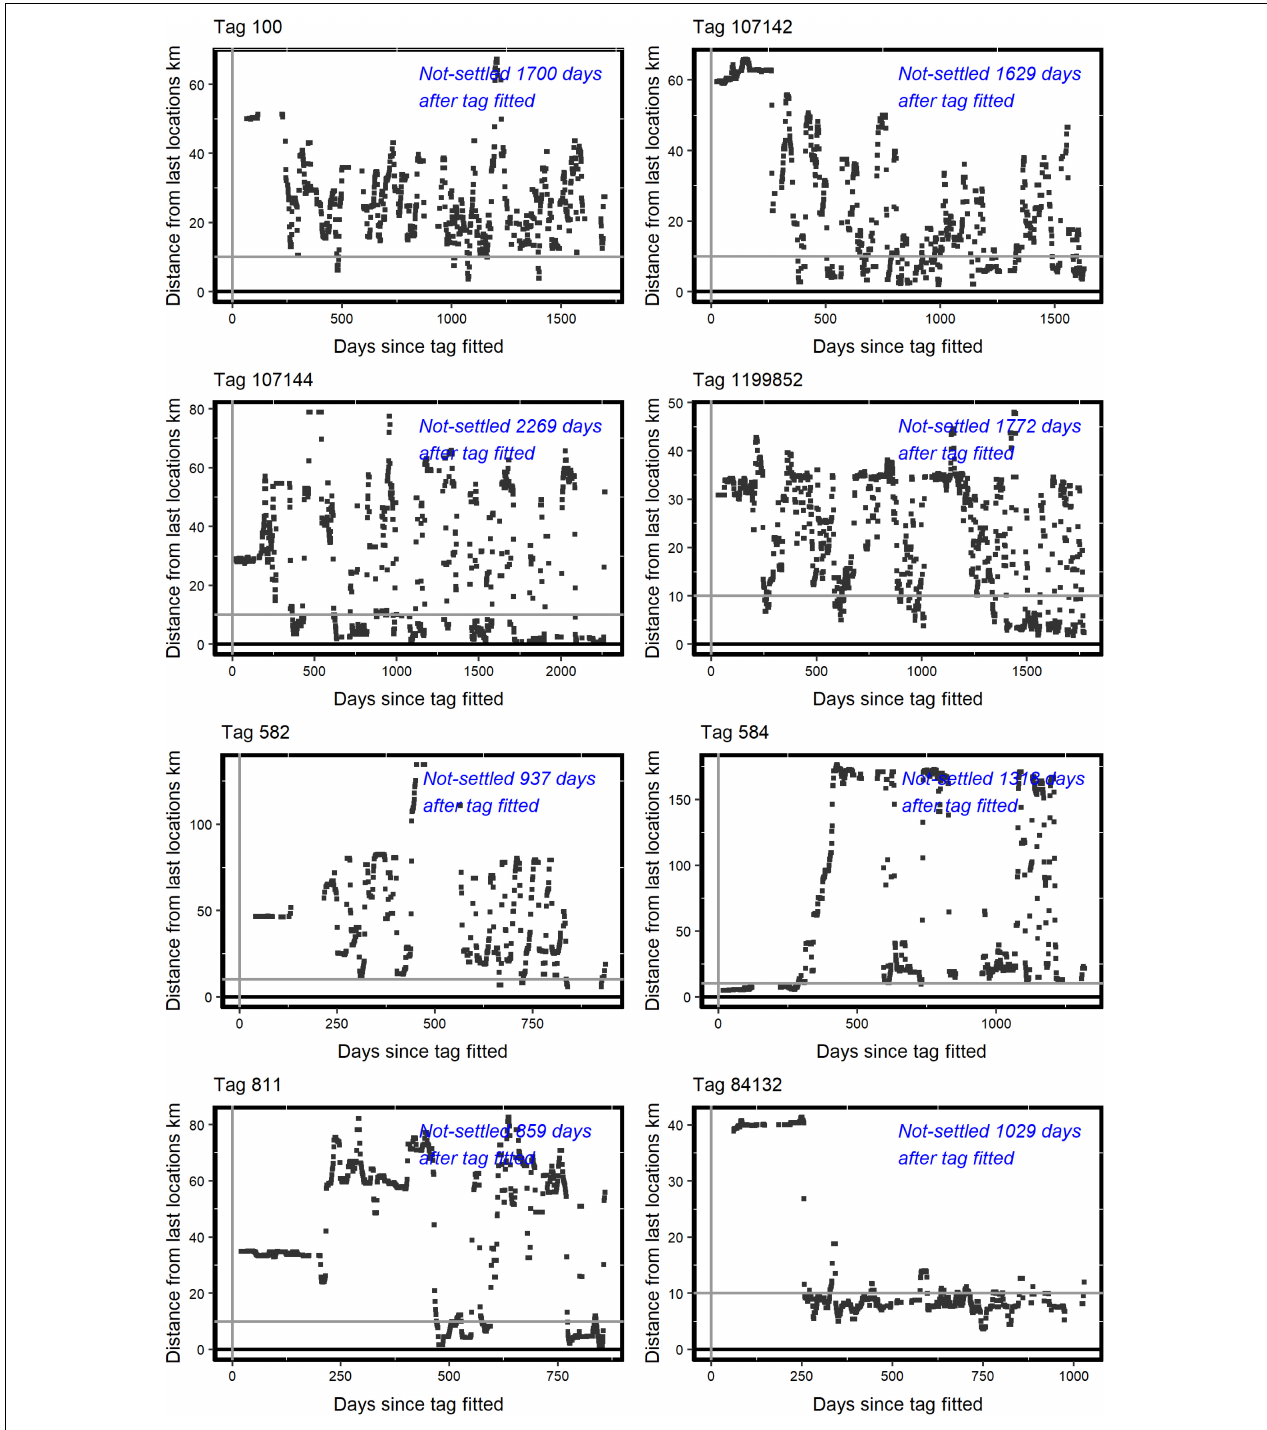
FIGURE 3 | Examples for eight tagged birds (identified, upper left above each panel) deemed not to have algorithmically settled on a putative breeding territory according to Distance from last locations (km) in the Y axes, against Days since tagged fitted in the X axes. The Y axes values were based on available median nocturnal locations and refer in distance to the median location 10 days earlier. The horizontal grey line shows the Assumption 2 threshold of 10 km for territory settlement (see main text). The italicised blue text (in days: top right within each panel) shows the time between tagging and the study’s temporal data cut-off which were available to ascertain that the tagged bird had not yet settled on a putative breeding territory. The R code in Supplementary Appendix B provides for such plots.